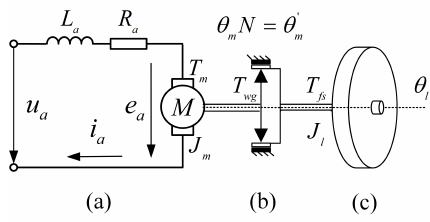
Figure 2. Control system diagram. ( a ) Motor; ( b ) Harmonic drive; ( c )